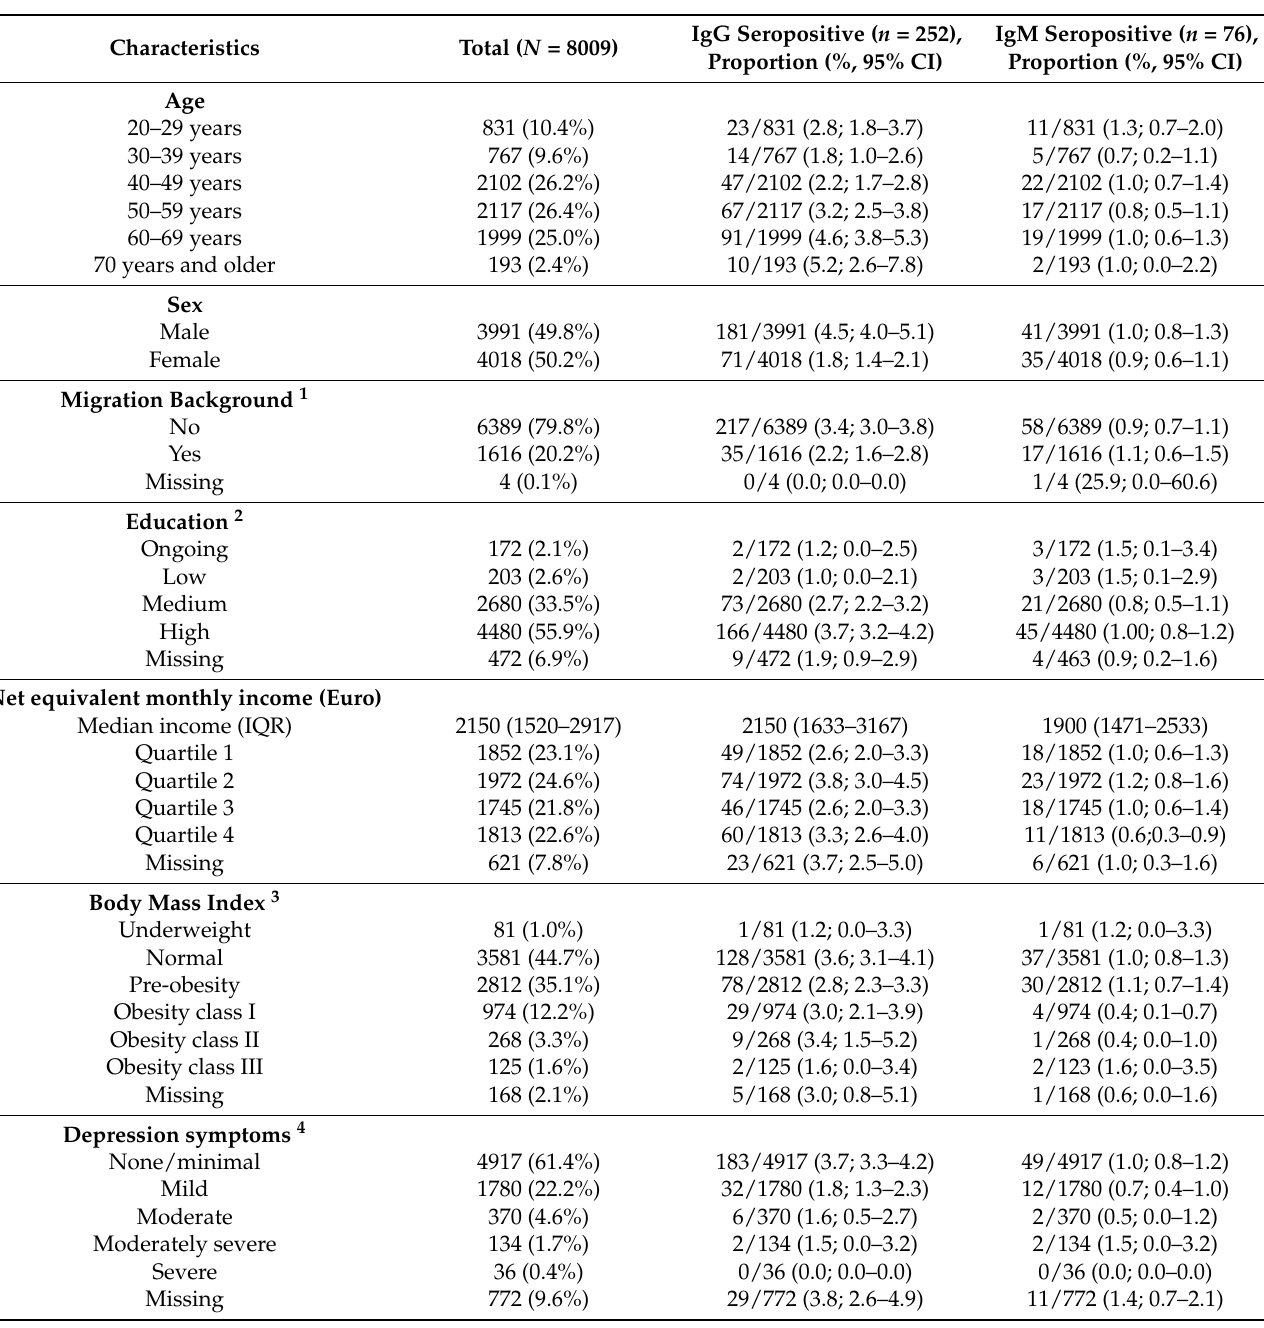
Table 1. Population characteristics and crude seropositivity for Borrelia burgdorferi